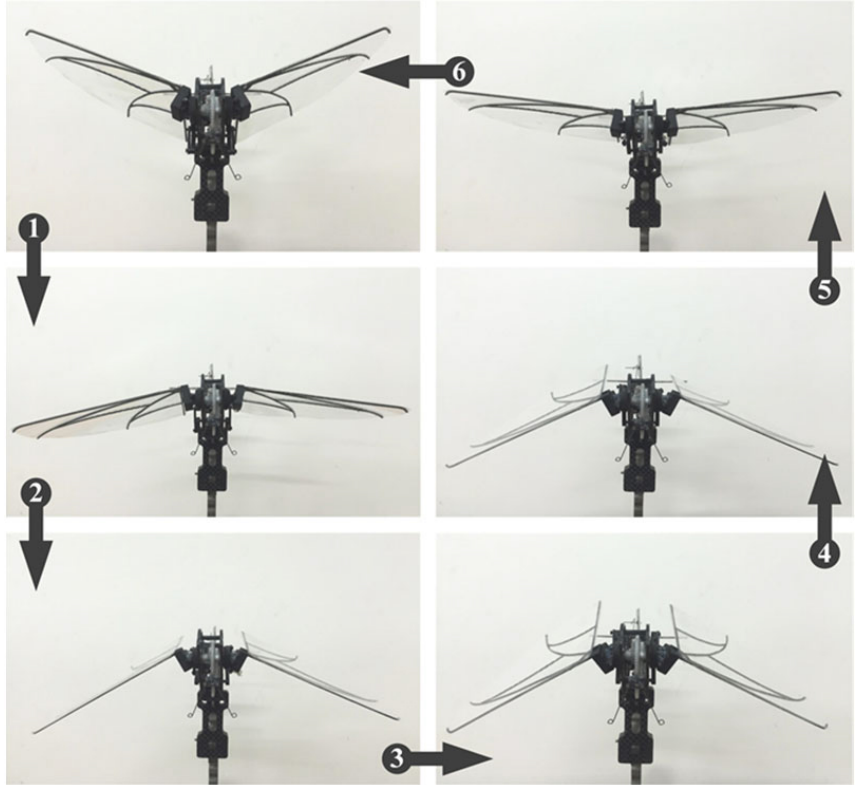
Figure 7. Whole flapping cycle front